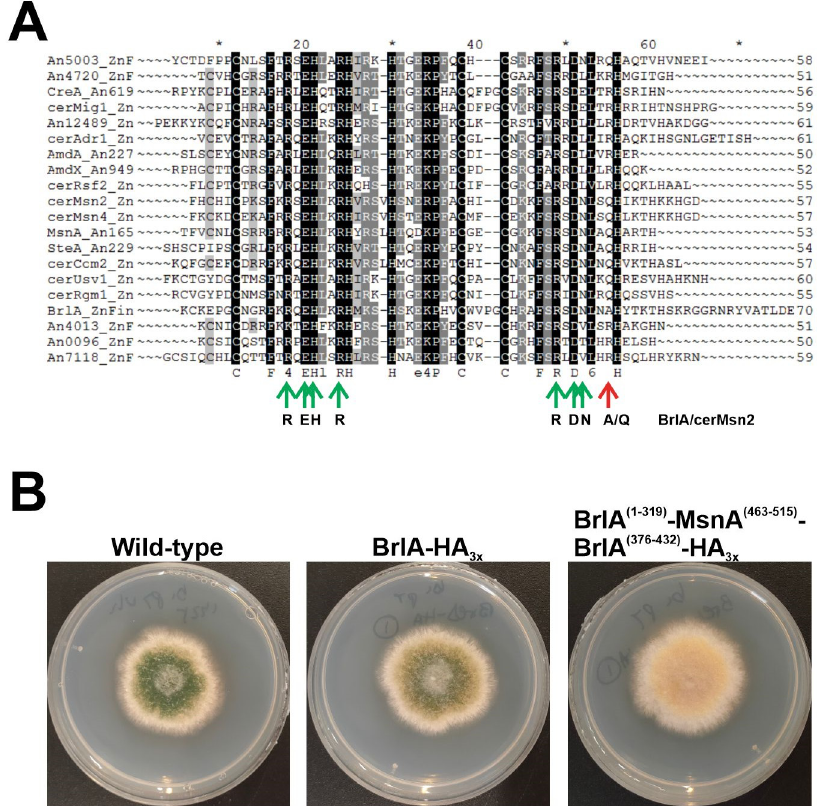
Figure 7. Similarities of the C2H2 domain of BrlA with those of specific regulators of sexual development and stress-response. ( A ) Alignment of the C2H2 DBDs of specific A. nidulans and S. cerevisiae (cer) TFs. The position and nature of the predicted DNA-binding amino acids (based on [68]) are indicated in green (conserved in all sequences analyzed, including BrlA) or red (not conserved in BrlA). The picture was exported from Genedoc, version 2.7.000, and edited. ( B ) Phenotype of a strain expressing a BrlA::HA 3x chimera in which the C2H2 domain of BrlA (residues F320-H375) had been replaced by that of MsnA (residues T463-H515), after 72 hours of culture at 37 °C in adequately supplemented AMM, and compared to the parental wild-type strain and a strain expressing BrlA::HA 3x . The diameter of plates is 5.5 cm.